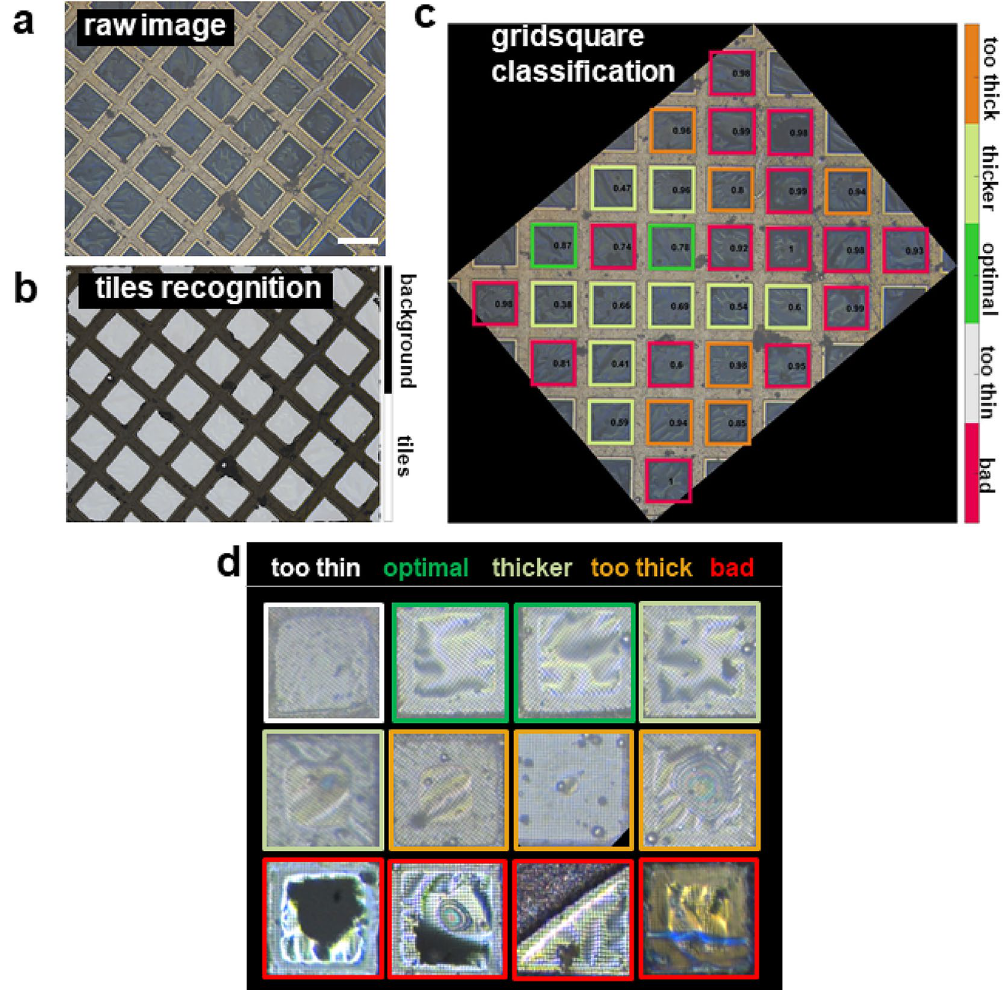
Figure 2. ANN analysis of the interferometric images for the determination of ice quality. ( a ) Raw interferometric image of a copper grid coated with sample prior analysis by ANNICAS. Scale bar 50 µm. ( b ) The same image overlaid with the tiles (in grey) as recognized by the segmentation network after complete training (see main text and Methods). All tiles were correctly identified. ( c ) The same image as in ( b ) after full analysis and grid square classification with the fully trained classification network. The image was rotated during analysis. The grid squares are highlighted with colours according to the ice layer quality. Five classes for grid squares quality were defined: bad (class 0, in red), too thin (class 1, in white), optimal (class 2, in green), thicker (class 3, in bright green) and too thick (class 4, in orange), respectively (colour legend indicated on the right). Numbers indicate confidence of ANN. ( d ) Examples of grid square classification for a wide spectrum of different interferometric images. Ice thickness of grid squares ranged from ‘too thin’ (in white) to too thick (in orange), with also grid squares with ice thickness in between (in green or light green), or with grid squares presenting large defects (in red). Colour-code for ice quality shown on the